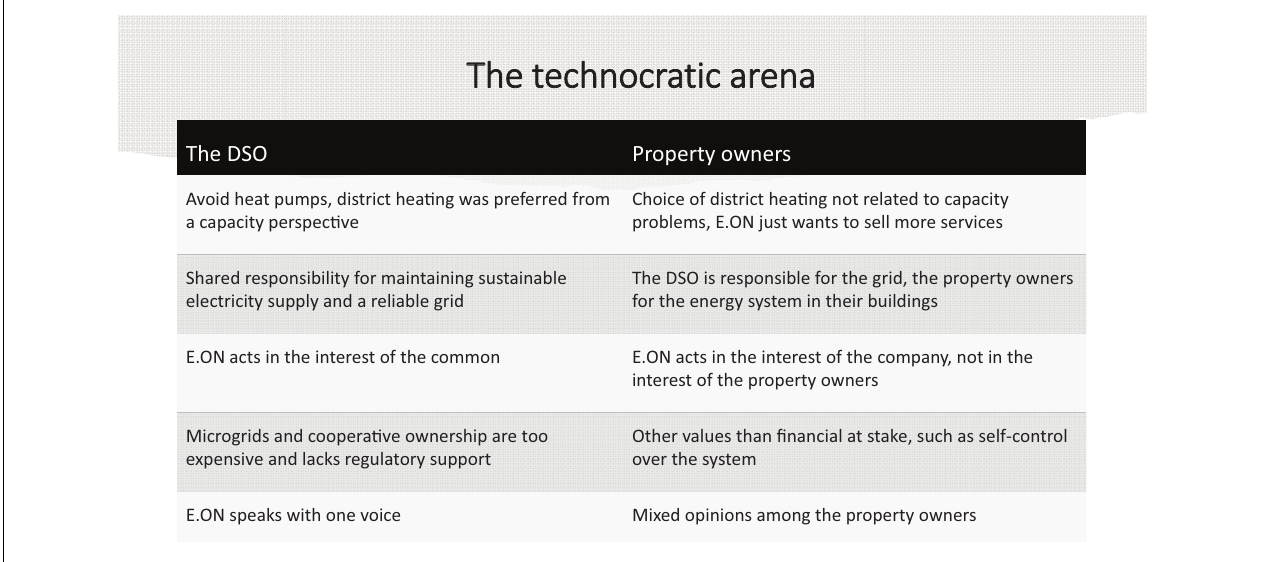
FIGURE 4 | A summary of the main arguments by the DSO and the property